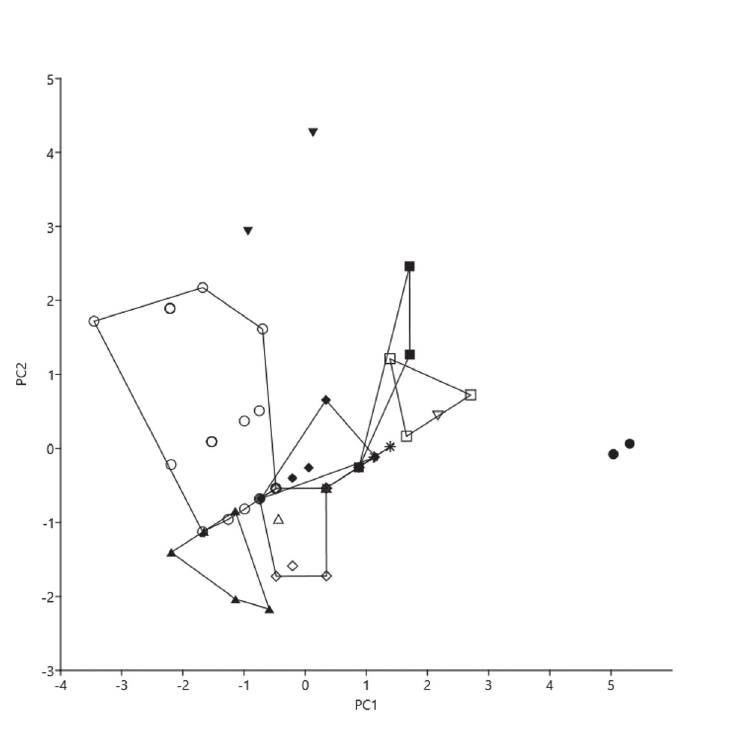
Fig. 6. Scatterplot of PC2 against PC1 for a PCA on 8 meristics (n = 60) of E. cf . miolepis (Boulenger, 1902) specimens from the Congo basin (excluding types): ‘Kisangani region’ 1 (◊), Ituri 1 (♦ ), Itimbiri ( ∆), Léfini (▲ ), Epulu 1 ( ○), Inkisi (●), Luapula 1 (□), Luki 1 (■ ), Luapula 2 ( ), Luapula 3 (▼), Ituri 2 (+), and Luki 2 ( ). Specimens from Luapula 1 and Luapula 2 can be separated from each other based on a PCA on the log-transformed measurements; specimens of Luki 2 fall separated when barbel lengths are included; specimens from ‘Kisangani region’ 1 and Itimbiri can be distinguished based on colour